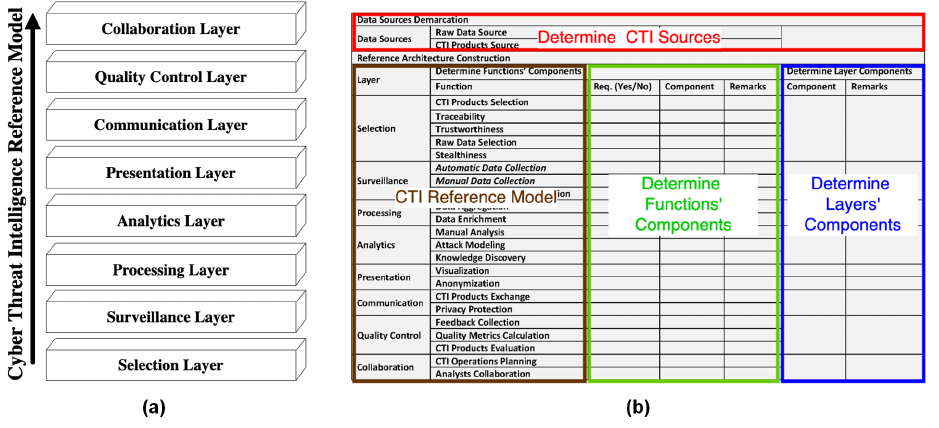
Figure 1. CTI: ( a ) Reference Model, ( b ) Reference Model Application